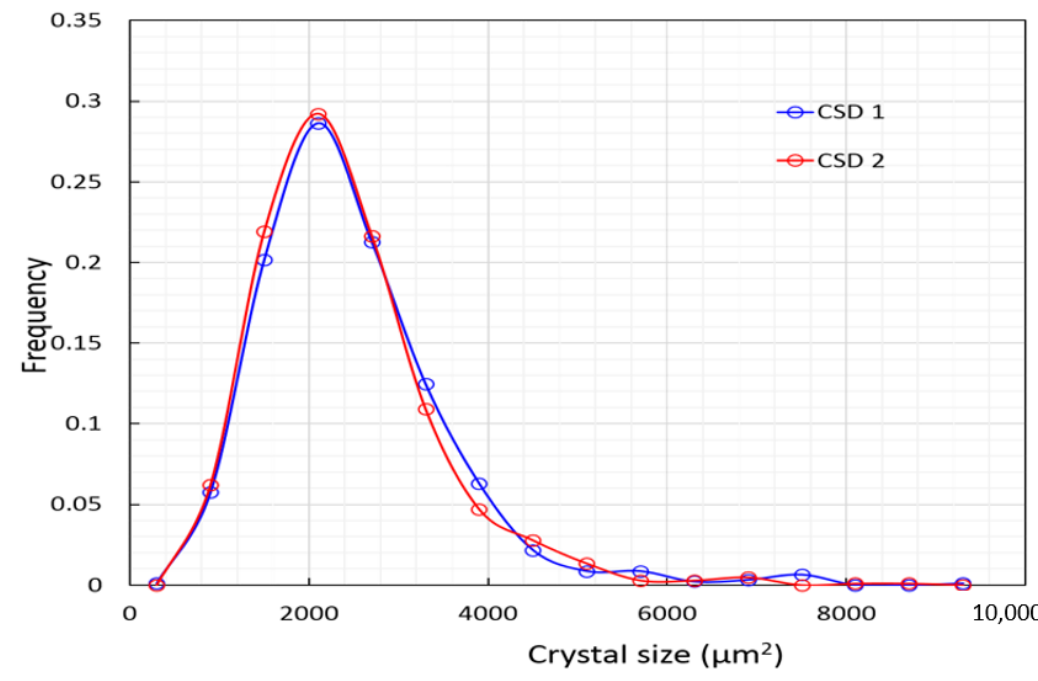
Figure 18. A lognormal crystal size distribution (CSD). CSD1 and CSD2 are the CSDs of two crystal populations that have precipitated from a Ca 2+ and SO 42 − enriched mixture of 85% wt. Dead Sea brine and 15% wt. seawater. The data are reprinted from Reiss et al. [158] with permission from the American Chemical